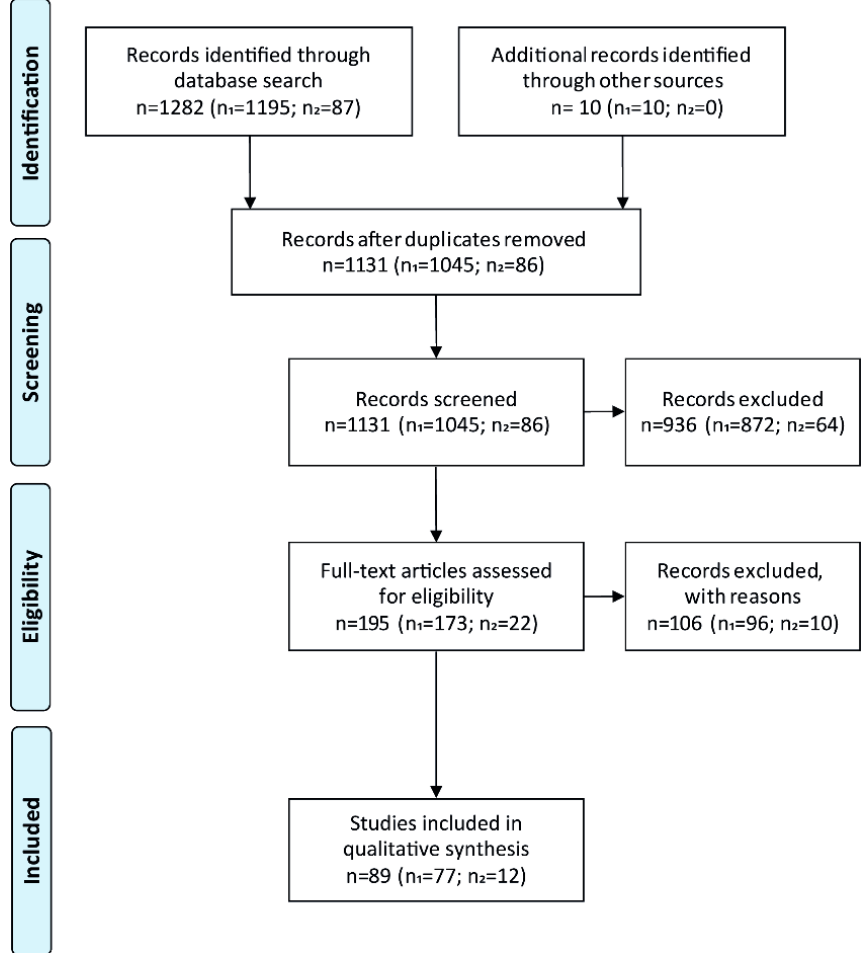
Figure 2. PRISMA-Flow diagram showing the selection of studies included in the systematic review. The number of studies reporting genetic variants and vitamin D status as well as the number of studies reporting genetic variants together with muscle mass and function, are given in parenthesis (n 1 and n 2).